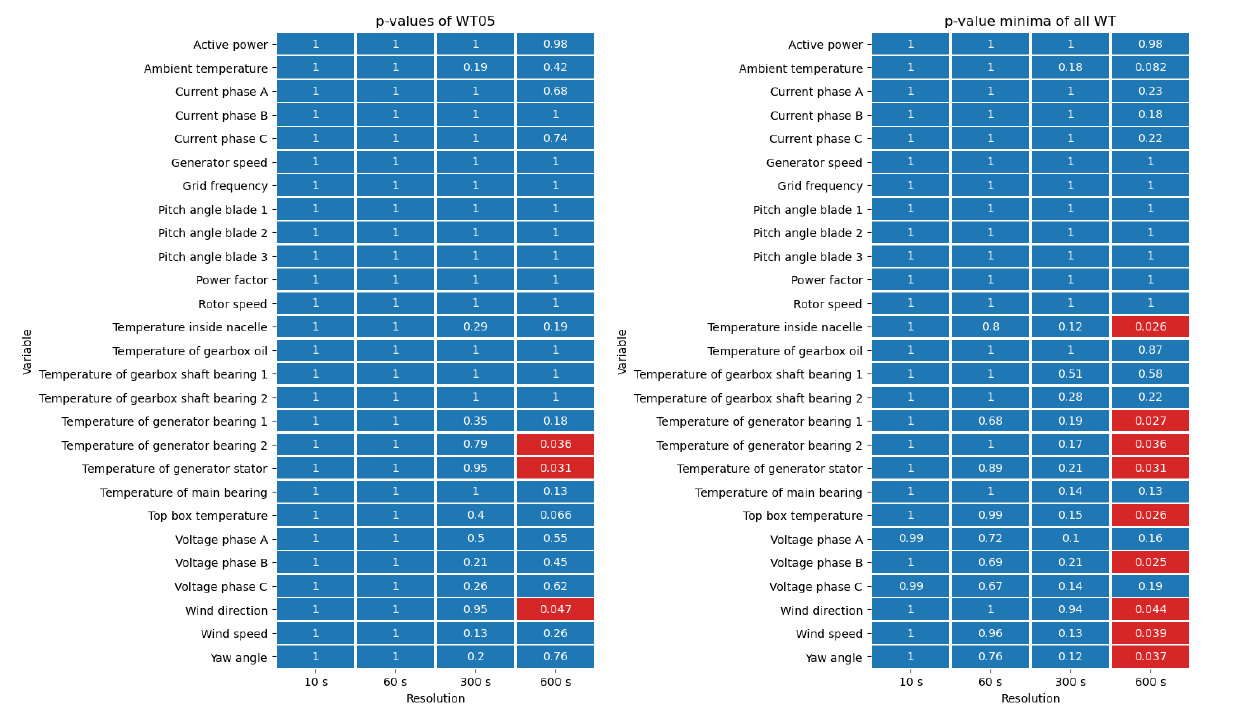
Figure 3. Calculated p -values of conducted KS tests for all signals at different levels of temporal aggregation for one exemplary turbine WT05 on the left and the minimum value of each cell of all turbines on the right. Cells with a red tint are below the level of significance, the blue ones